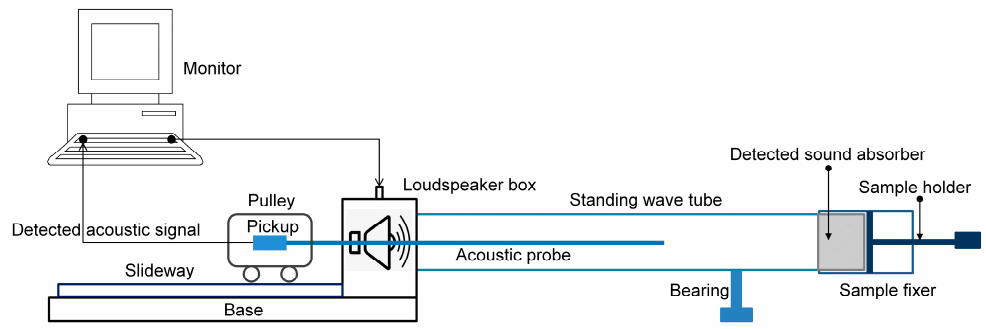
ffi cient measurement.